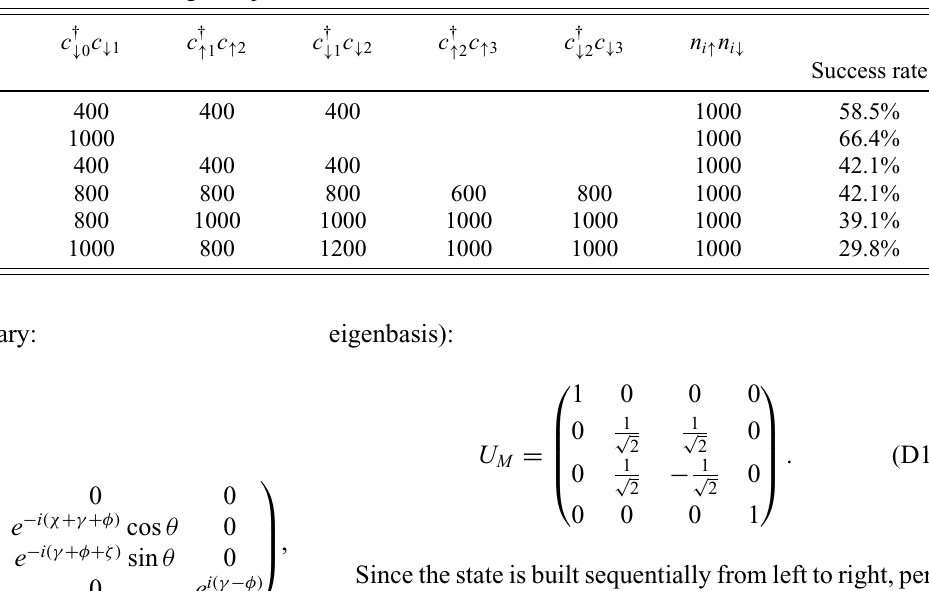
TABLE I. Total shots for different measurements ( i = 1, 2, 3 for 1 / 3 -filling states and i = 1, 2 for 1 / 2 -filling states), success rate defines the proportional of total shots kept after the noise-mitigation